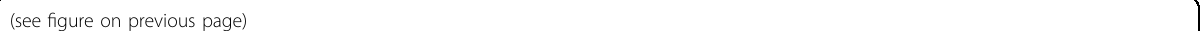
Fig. 1 Genomic copy number deletion of MIR99AHG from 21q leads to the downregulation of MIR99AHG and miR-99a in LUAD. a Heatmap of differentially expressed lncRNAs in human LUAD tissues and normal tissues from the TCGA database. b Circos plot showing the association between the differentially expressed lncRNAs and the arm-level CNVs. c Schematic diagram of MIR99AHG family noncoding RNAs. MIR99AHG gene located on 21q, a copy number deletion arm, could transcribe lncRNA MIR99AHG and the miR-99a/let-7c/miR-125b2 cluster simultaneously. d Expression levels of MIR99AHG ( P < 0.001) and miR-99a ( P = 0.005) in the TCGA cohort. e Expression levels of MIR99AHG ( P = 0.003) and miR-99a ( P = 0.016) in the 30-patient cohort. f and g Correlation between expression levels of MIR99AHG and miR-99a in the TCGA cohort ( r = 0.614, P < 0.001) or 30-patient cohort ( r = 0.644, P < 0.001). h Expression level of the MIR99AHG gene in LUAD cell lines, with TPTE used as the internal control. i and j Expression levels of MIR99AHG ( i ) and miR-99a ( j ) in LUAD cells, with GAPDH and U6 used as the internal controls, respectively. k Expression level of the MIR99AHG gene in LUAD tissues and adjacent normal tissues from the 30-patient cohort ( P < 0.001). l Correlation between MIR99AHG genomic expression level and MIR99AHG ( r = 0.607, P < 0.001) or miR-99a ( r = 0.578, P < 0.001) expression level in the 30-patient cohort. m Correlation between MIR99AHG genomic expression level and MIR99AHG ( r = 0.112, P = 0.012) or miR-99a ( r = 0.168, P < 0.001) expression level in the TCGA cohort. A two-tailed Student ’ s t -test was used for statistical analysis. * P < 0.05, ** P < 0.01, *** P < 0.001, n.s. not statisticly signi fi cant. Error bars,